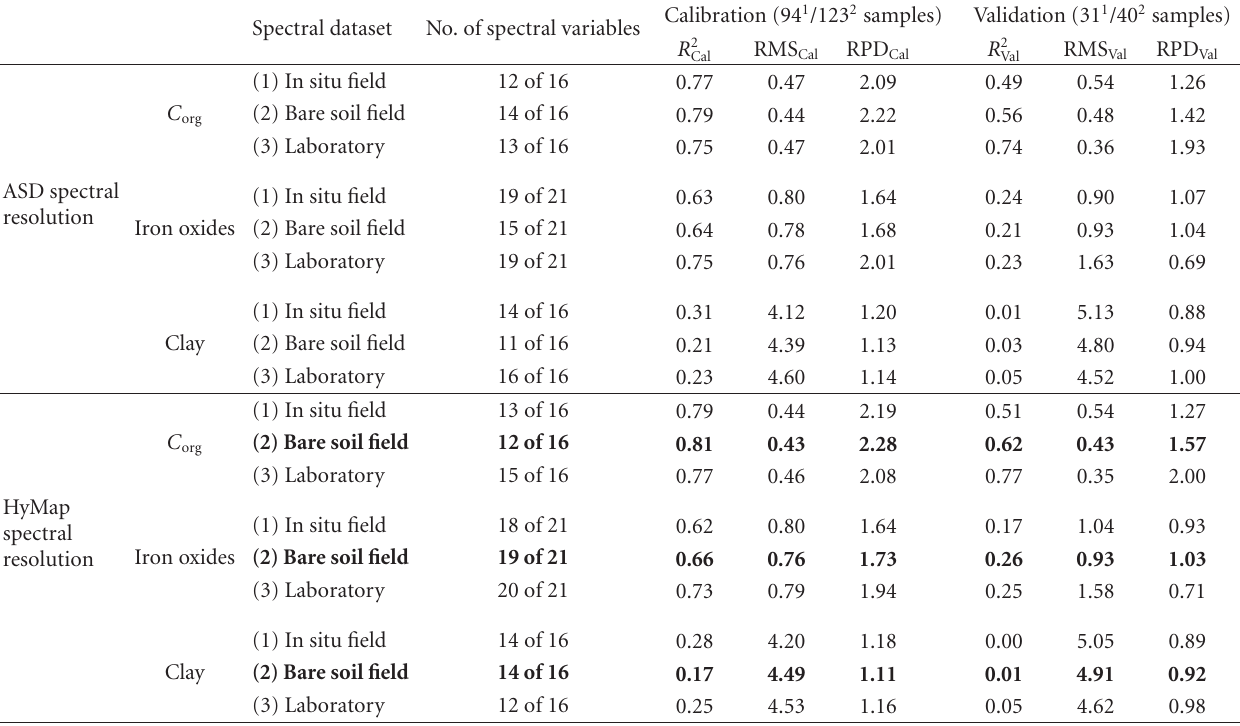
Table 3: Calibration and validation accuracies for approach A—Multiple linear regression of spectral parameters. The models further to be applied for a large-scale prediction of soil constituents based on HyMap imagery are